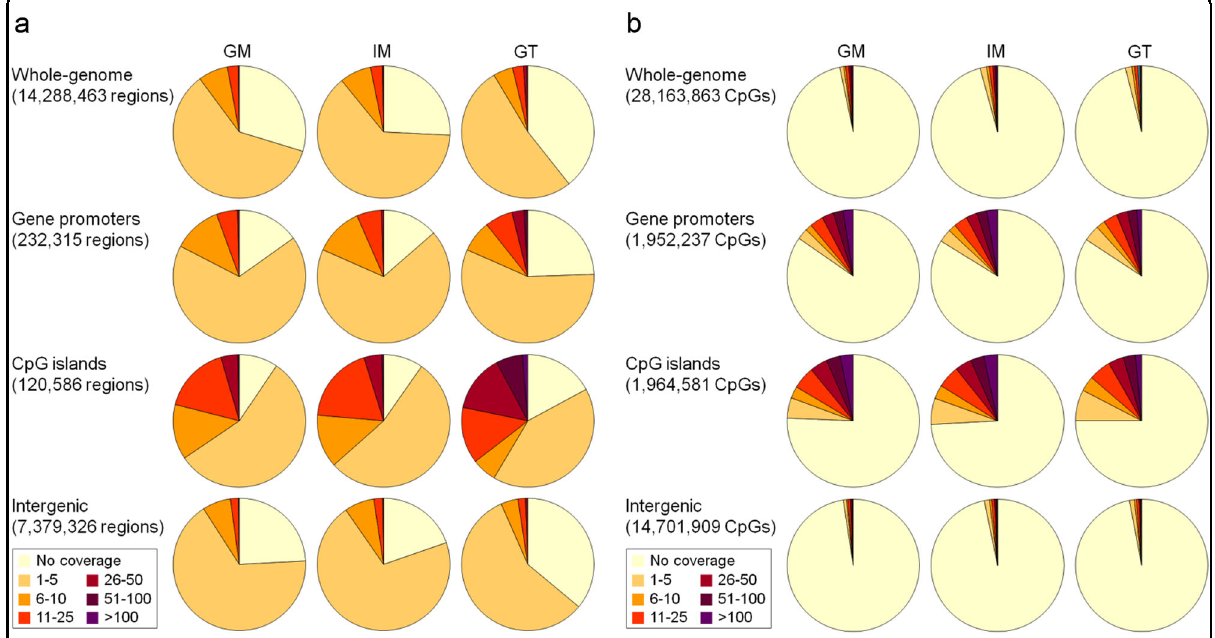
Fig. 2 Genome coverage of the methylation signatures from the MBD-seq and RRBS data of samples from a patient with GC. ( a ) For the MBD-seq analysis, the methylation enrichment signatures were searched by 200 bp sliding on the whole-genome, gene promoters (2 kb regions centered on TSSs from RefSeq), CGIs, and intergenic (intergenic regions without promoters) regions. ( b ) For the RRBS analysis, the genomic coverage was assessed at the single base level in the same regions as those included in the MBD-seq